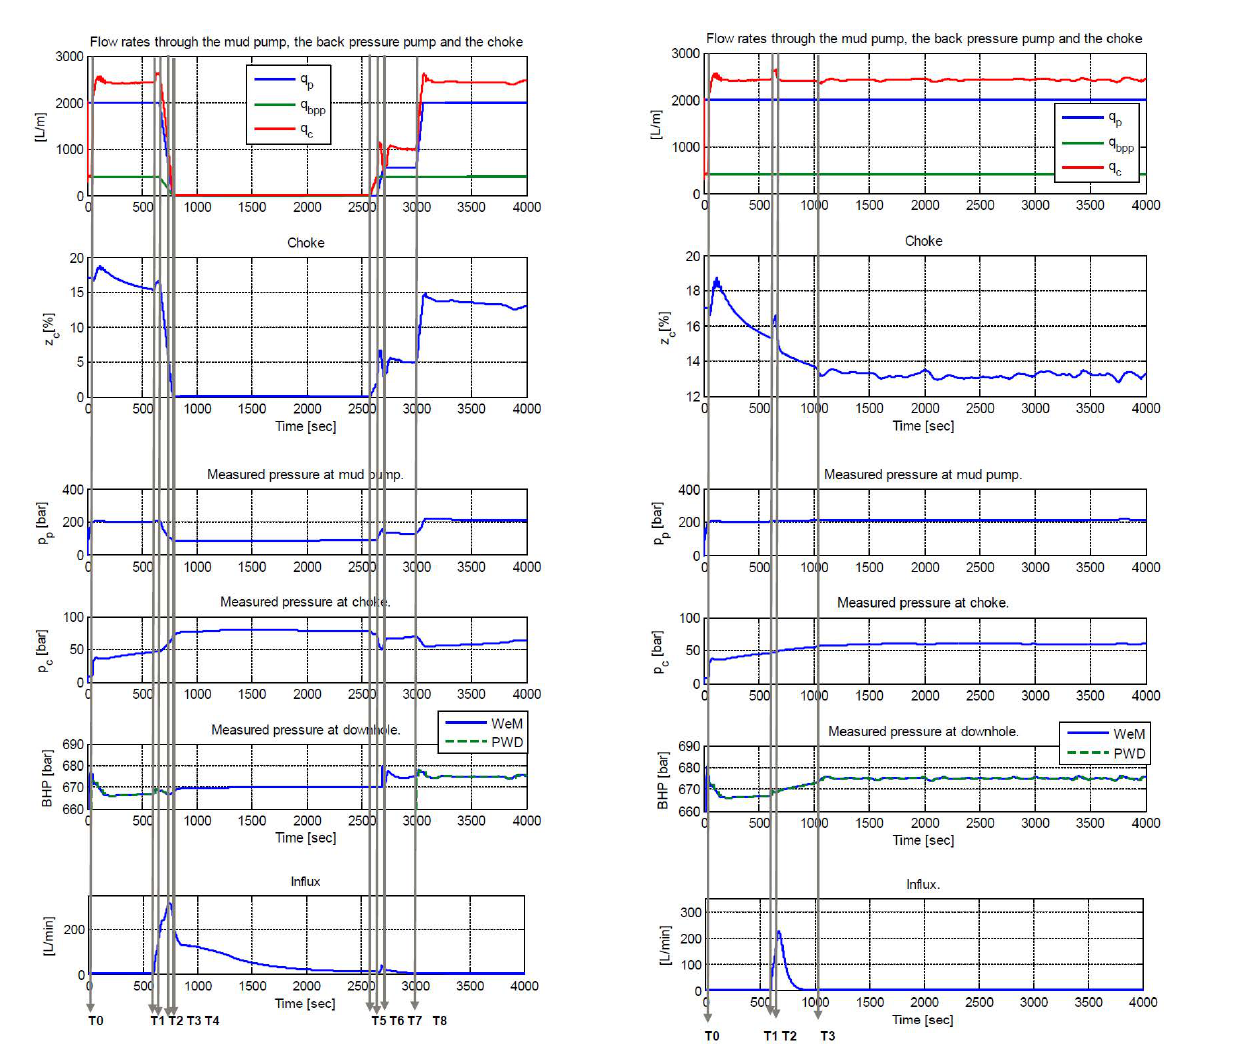
Figure 6: Case 4: Flowrates, choke opening, measured pressure and Influx flow rate using AKC on Well